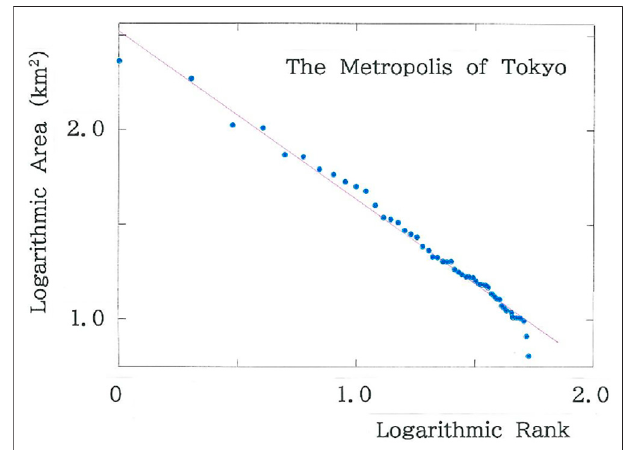
FIGURE 10 | Log-log plot for rank dependence of the areas of municipalities in the Metropolis of Tokyo ( n (cid:1) 53). The purple declining line indicates the optimized fi t (| r | (cid:1) 0.9912 with d (cid:1) 0.792 < d L